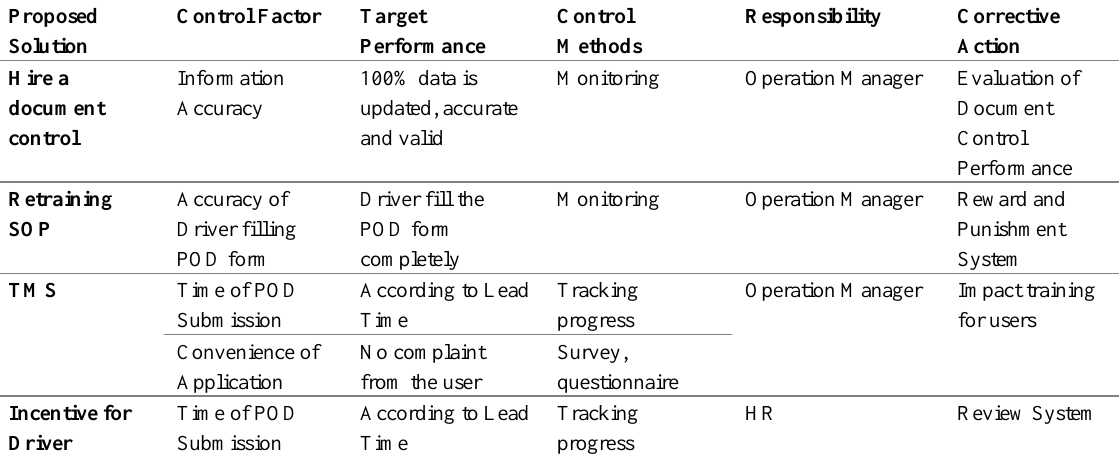
Table 5: Control Plan for Proposed